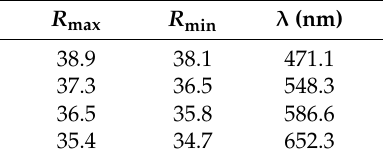
Table 1. Reflectance values for spiridonovite.